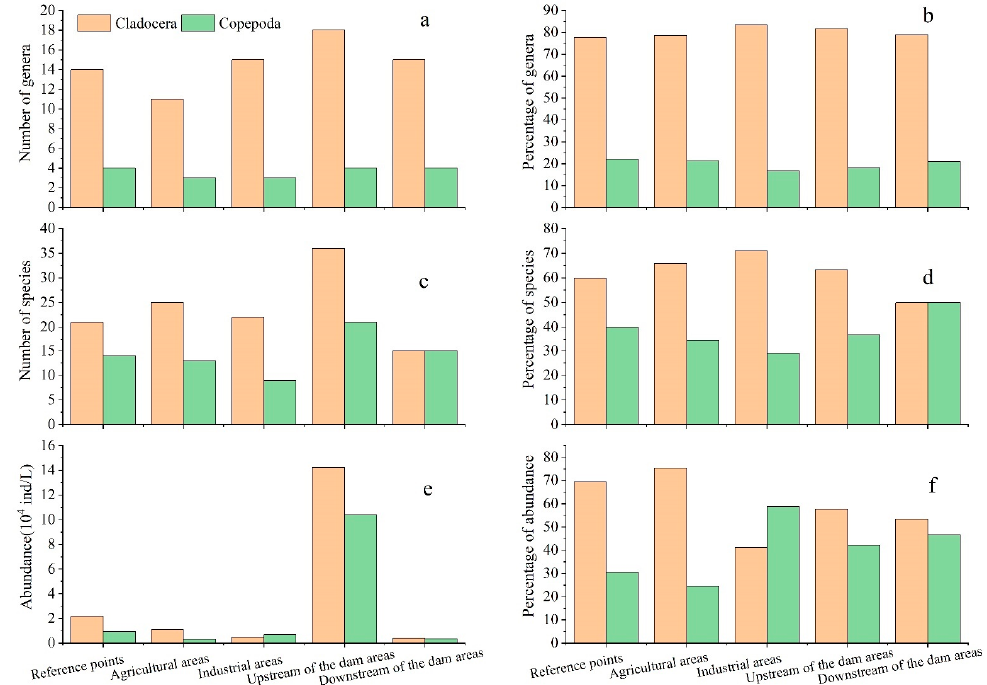
Figure 2. Zooplankton genera, species, abundance, and percentages in different areas of the Wanan River basin, China. ( a ): Number of Cladocera and Copepoda genera; ( b ): Percentage of Cladocera and Copepoda genera; ( c ): Number of Cladocera and Copepoda species; ( d ): Percentage of Cladocera and Copepoda species; ( e ): Abundance of Cladocera and Copepoda; ( f ): Percentage of Cladocera and Copepoda